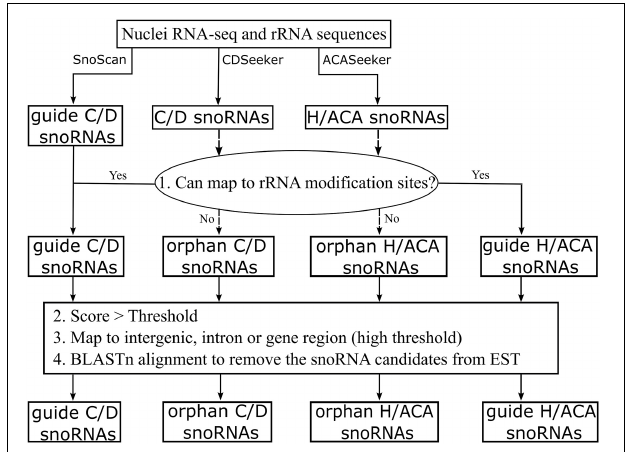
FIGURE 2 | Flowchart of identification and prediction of small nucleolar RNAs in the rubber tree.